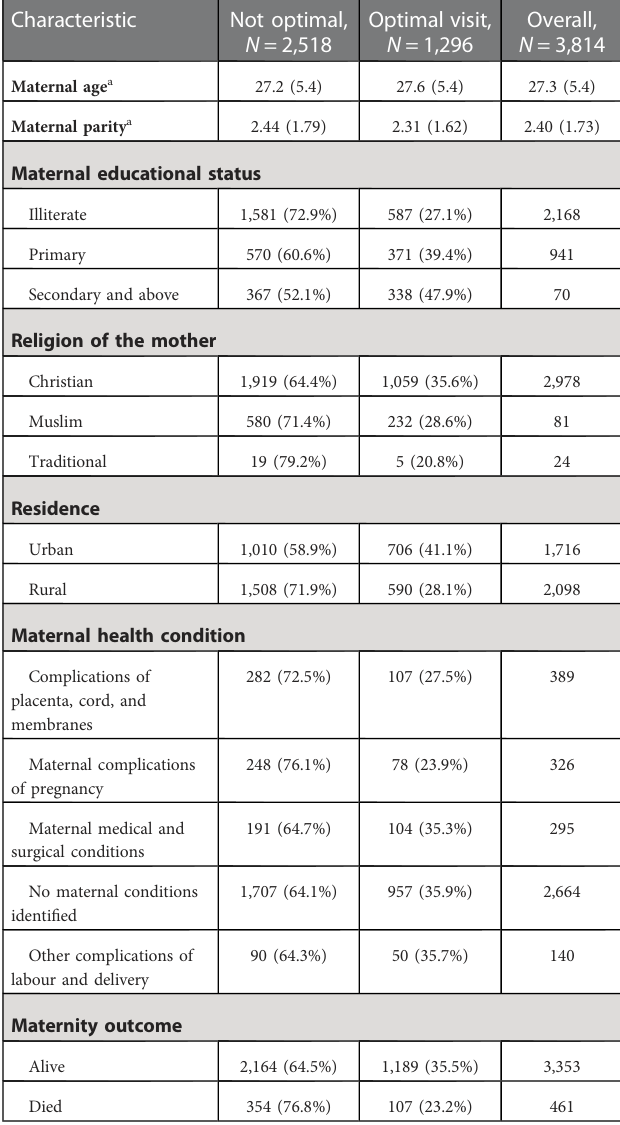
TABLE 3 Selected background characteristics of the deceased perinate ’ s mother by the level of follow-up in Ethiopia, 2021.